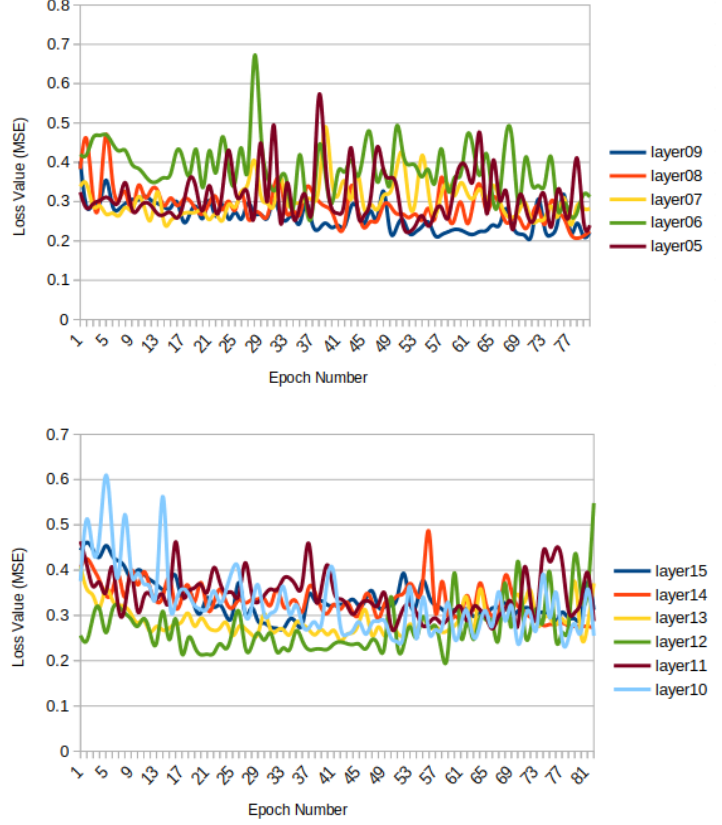
Figure 7. Loss values during training of models while utilizing features from different layers of the VGG-16 Network are shown. Layer 9 has the least Mean Square Error (MSE) value among Layers 5 to 9, whereas, layer 12 has the least MSE value among Layers 10 to